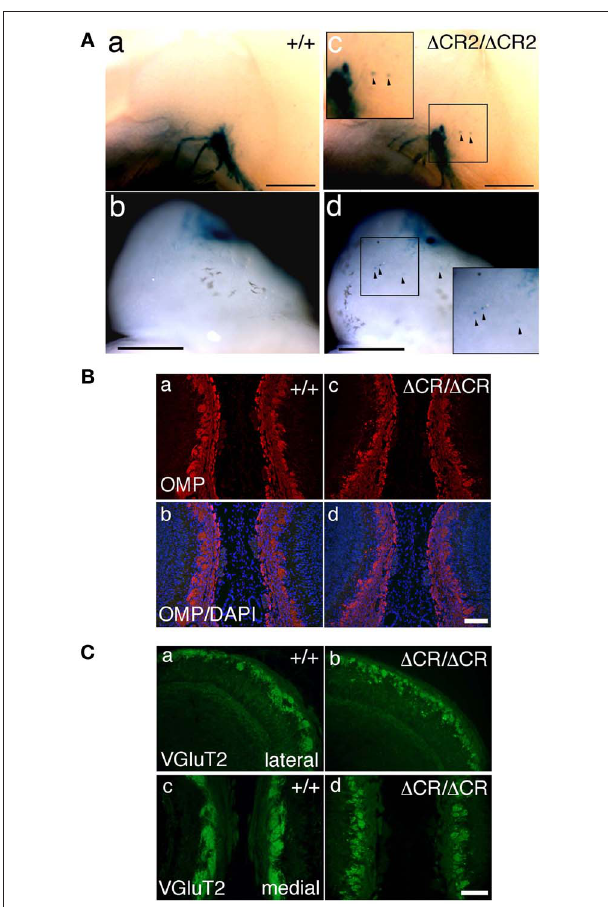
FIGURE 3 | Ectopic glomerulus-like structures of P2-expressing OSNs in neonatal Pcdha (cid:2) CR 2 /(cid:2) CR 2 mice found by whole-mount observation. (A) X-gal-stained P2 glomeruli in the P0 OBs of WT (a, b) or Pcdha (cid:2) CR 2 /(cid:2) CR 2 (c, d) mice. In Pcdha (cid:2) CR 2 /(cid:2) CR 2 mice, abnormal axonal projections from the olfactory nerve were often detected (arrowheads). Scale bars, 500 μ m. (B) Double staining with an anti-OMP antibody and DAPI in the P0 OBs in coronal sections of WT (a, b) or Pcdha (cid:2) CR /(cid:2) CR (c, d) mice. Scale bar, 100 μ m. (C) Immunostaining with an anti-VGluT2 antibody in the lateral (a, b) and medial (c, d) sides of the P0 OBs in WT (a, c) or Pcdha (cid:2) CR /(cid:2) CR (b, d) mice. Scale bar, 100 μ